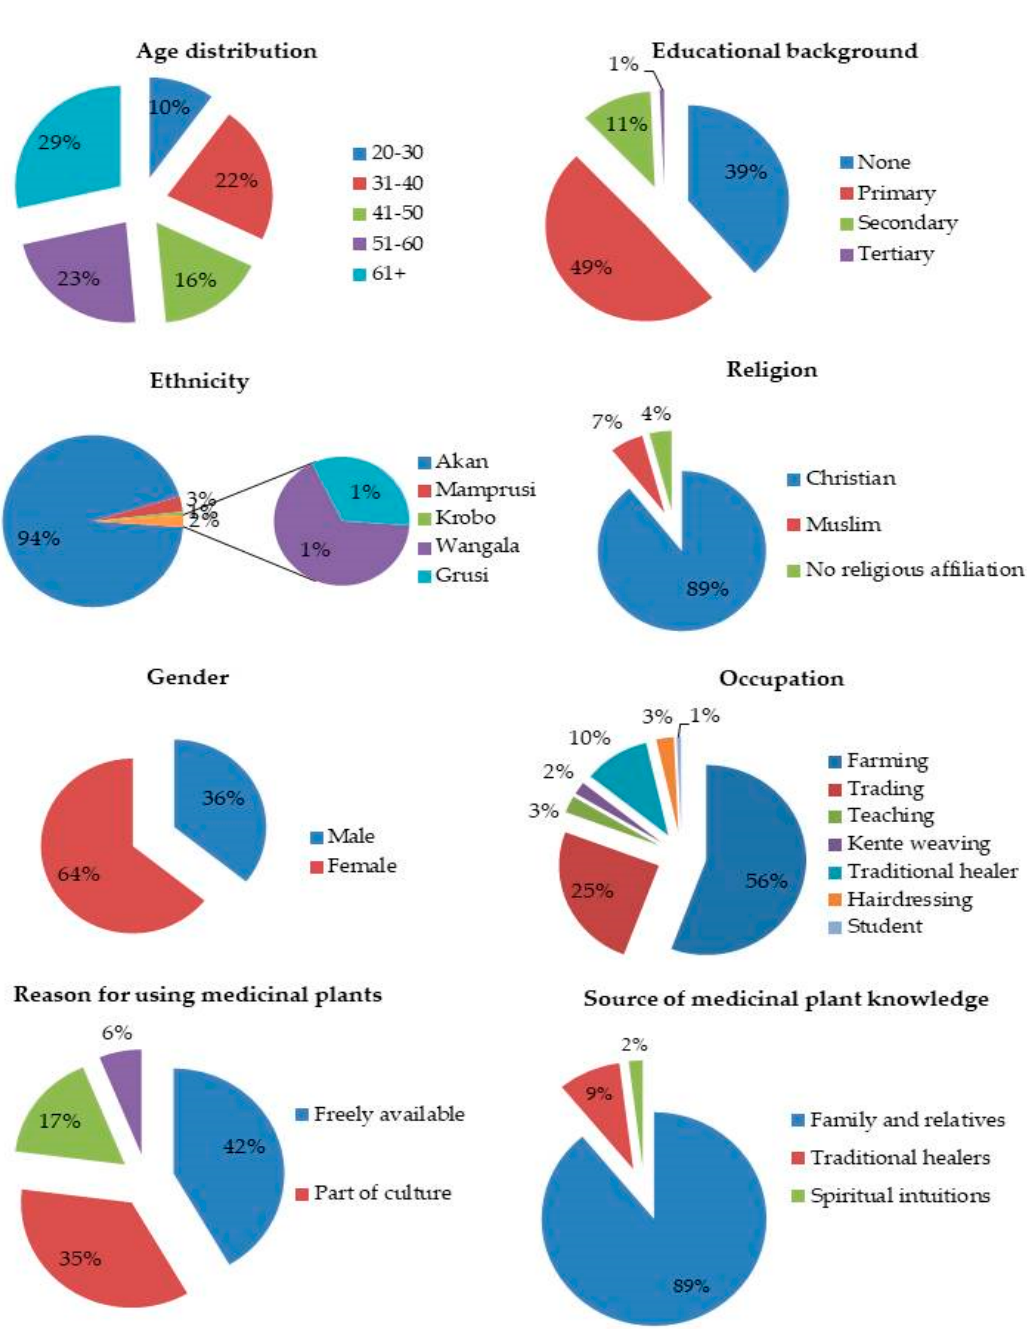
Figure 2. The demographic profile of the informants in Ejisu-Juaben Municipality.